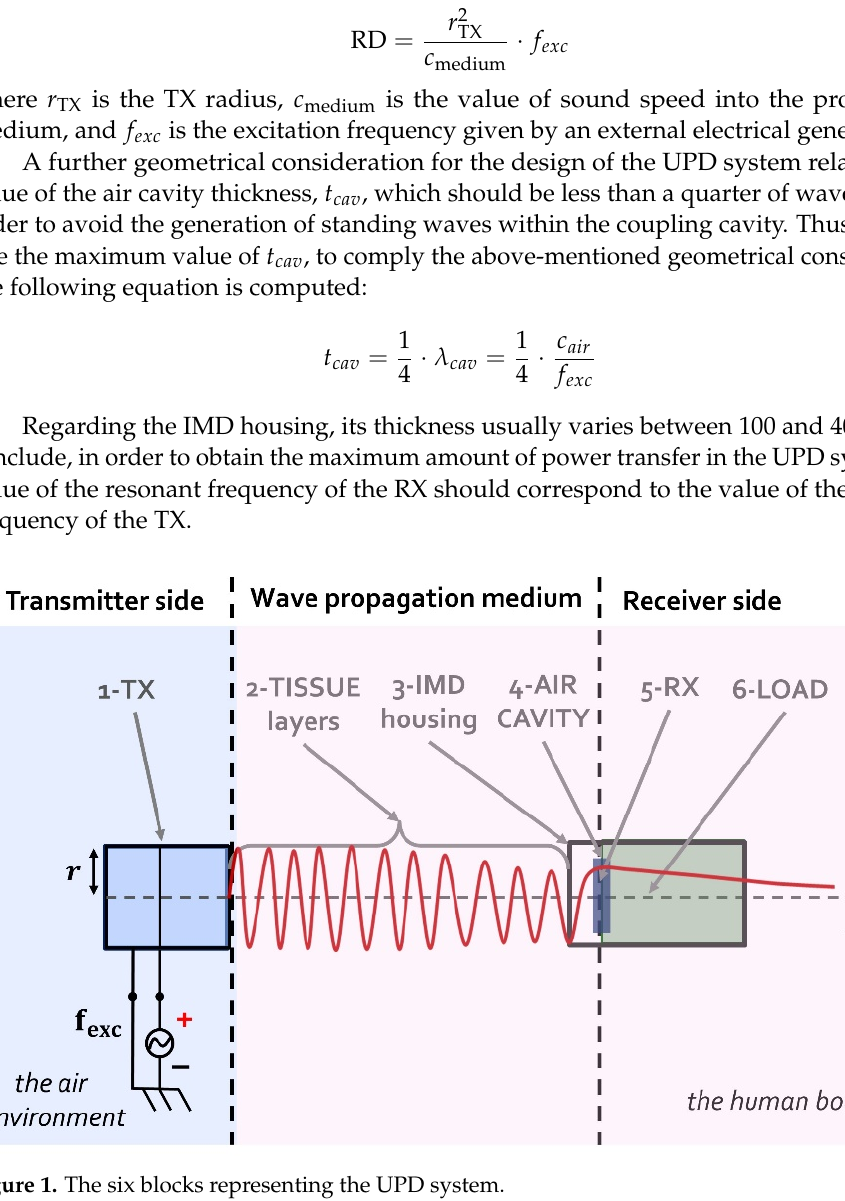
Figure 1. The six blocks representing the UPD system.